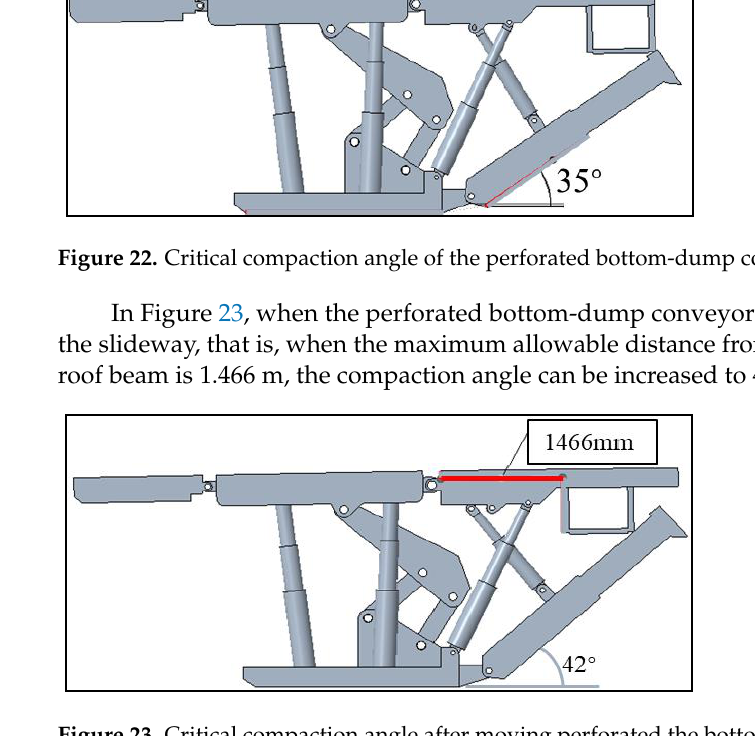
Figure 23. Critical compaction angle after moving perforated the bottom-dump conveyor.